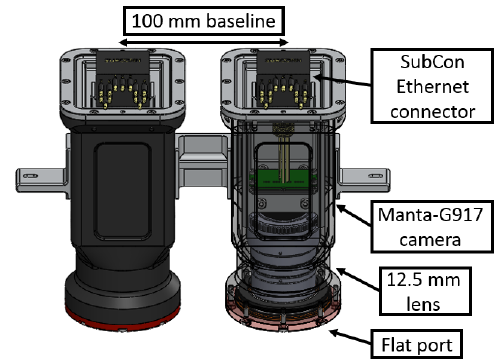
Figure 2. In-house developed stereo camera housing.